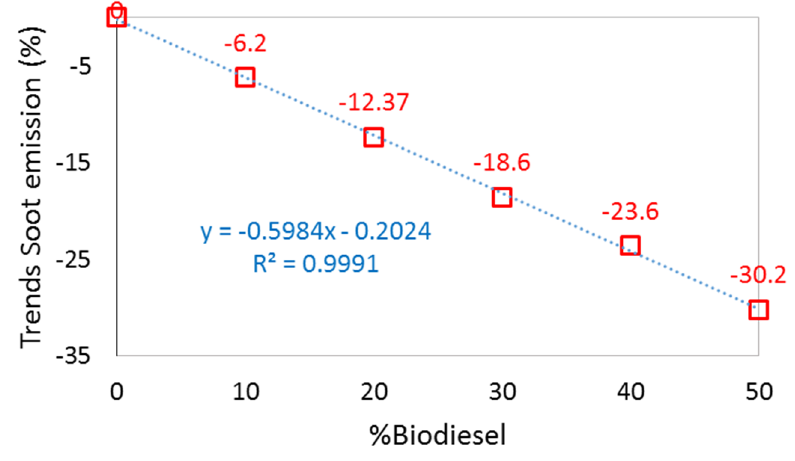
Figure 13. Trending Soot emission follows biodiesel blends.